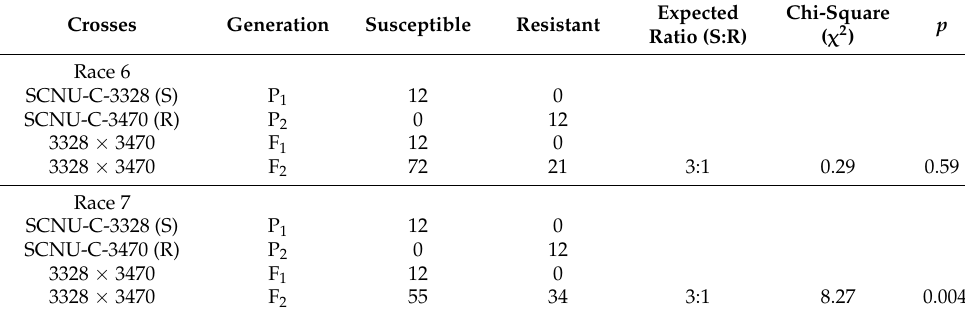
Expected Chi-Square p Ratio (S:R) ( χ 2 )